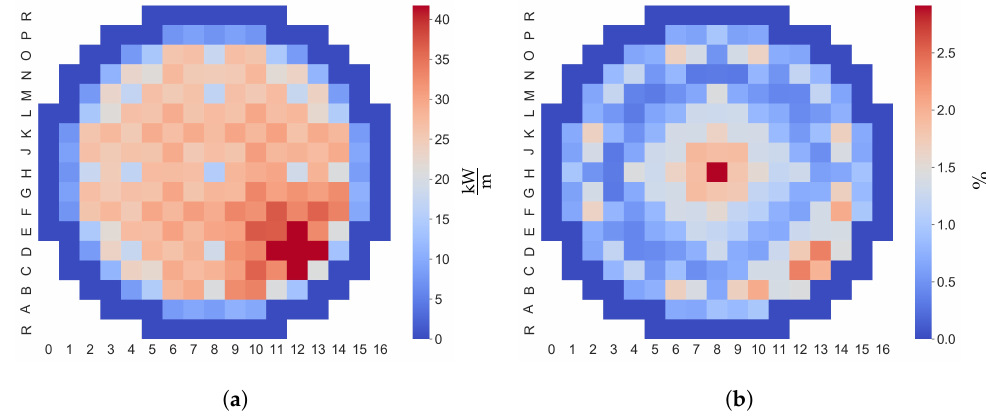
Figure 25. Radial profile of P ave